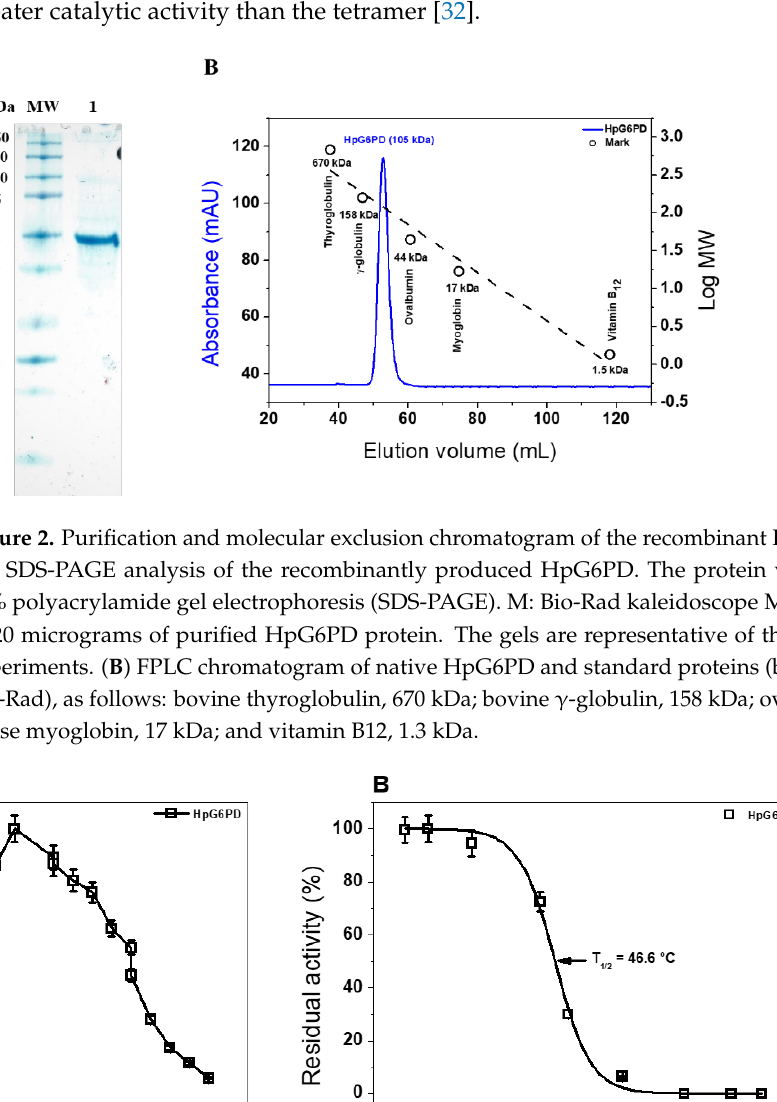
Figure 2. Purification and molecular exclusion chromatogram of the recombinant HpG6PD enzyme. ( A ) SDS-PAGE analysis of the recombinantly produced HpG6PD. The protein was analyzed on 12% polyacrylamide gel electrophoresis (SDS-PAGE). M: Bio-Rad kaleidoscope MW marker. Lane 1: 20 micrograms of purified HpG6PD protein. The gels are representative of three independent experiments. ( B ) FPLC chromatogram of native HpG6PD and standard proteins (black dashed line, Bio-Rad), as follows: bovine thyroglobulin, 670 kDa; bovine γ -globulin, 158 kDa; ovalbumin, 44 kDa; horse myoglobin, 17 kDa; and vitamin B12, 1.3 kDa.